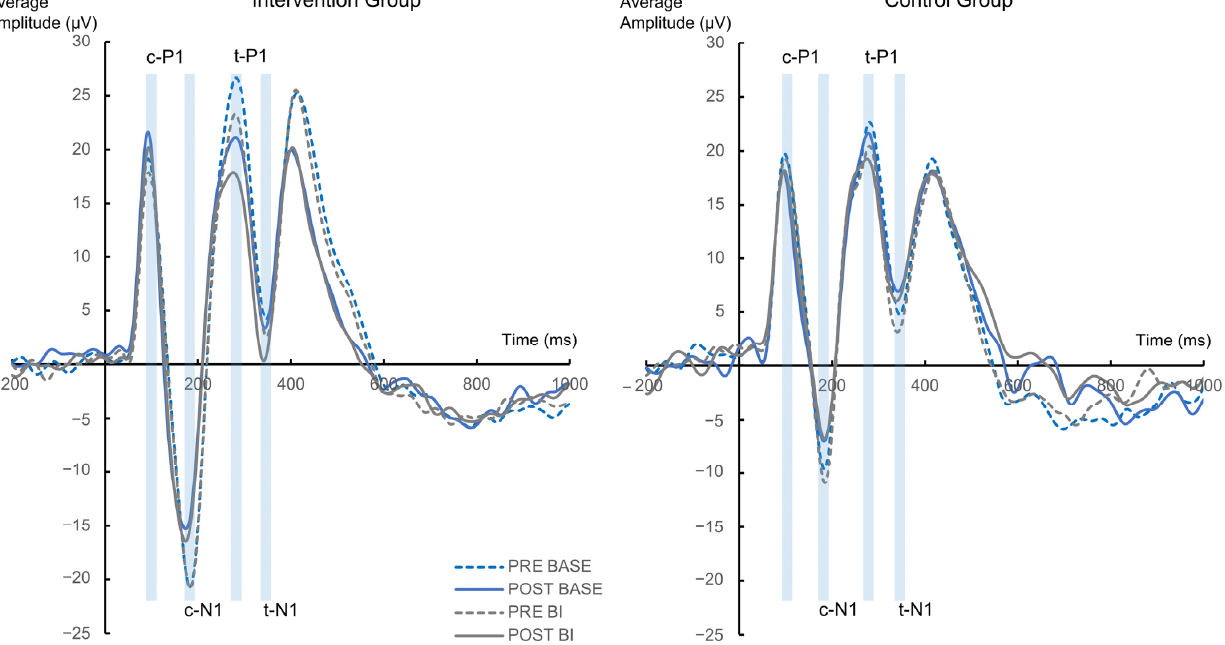
Figure 4. Cue-P1 (c-P1), cue-N1 (c-N1), target-P1 (t-P1) and target-N1 (t-N1) ERPs evoked by the cue or target stimuli pooled across electrode P7 and P8 are presented for the intervention group and control group separately. Time point zero denotes the onset of the cue; the target stimulus was added to the visual array 100 ms later.